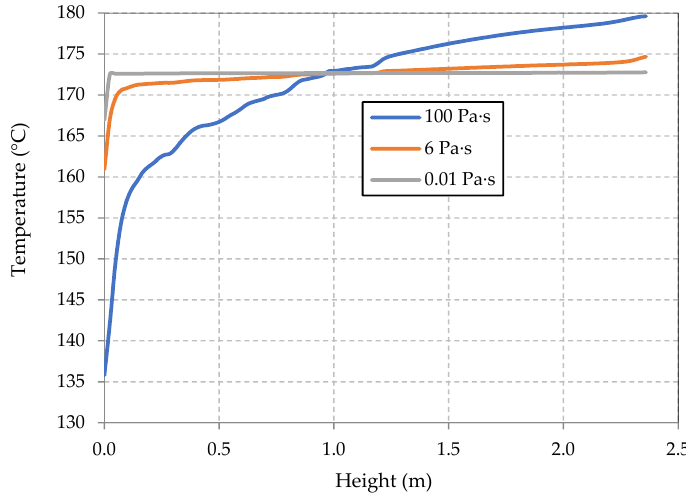
Figure 4. Vertical profile of the liquid temperature in the tank after 60 h.